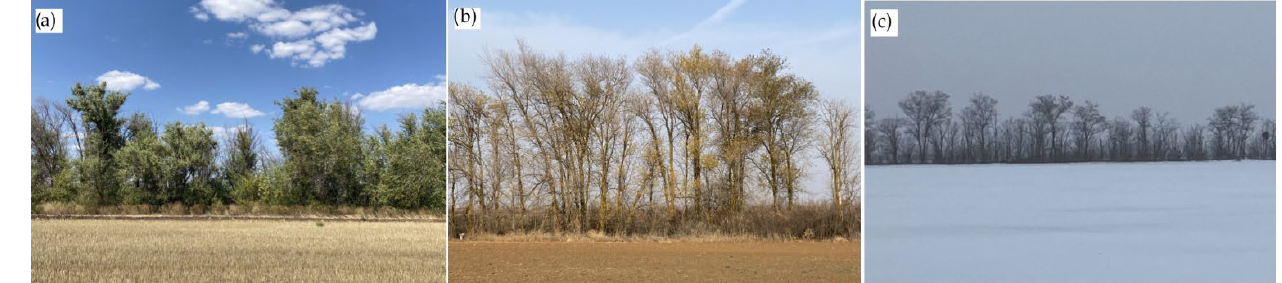
Figure 3. The forest belt during the periods of research: ( a ) summer 2020, ( b ) autumn 2020, ( c ) winter 2021.